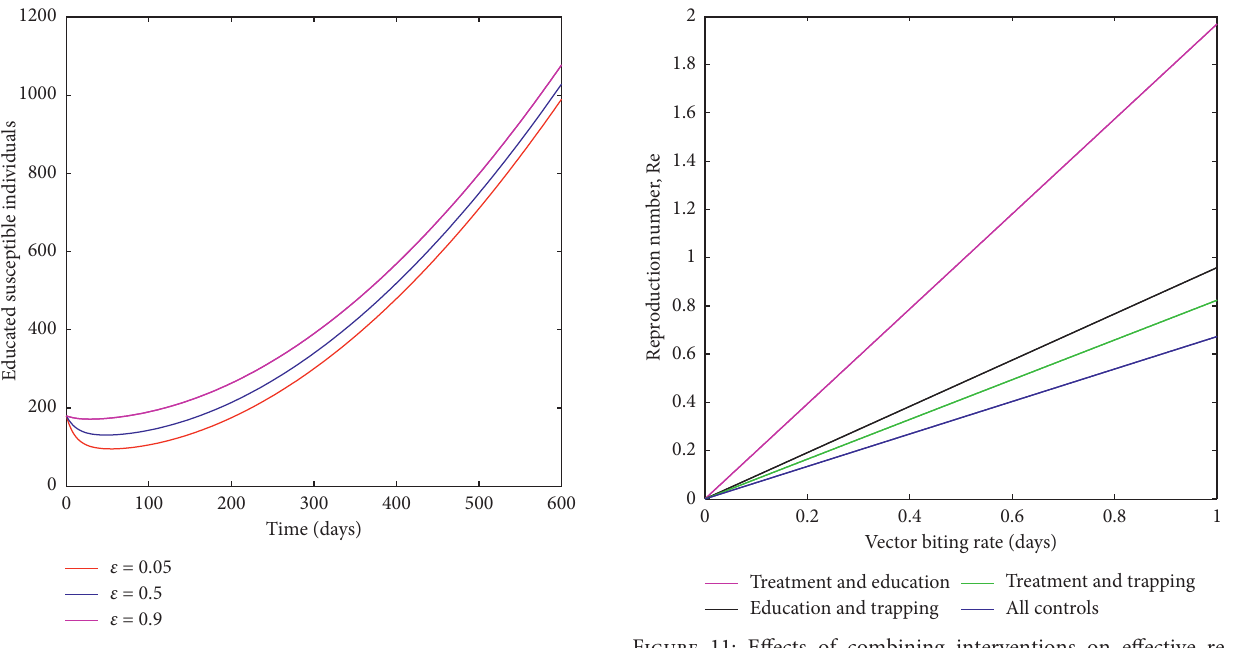
Figure 9: Variation in efficacy of public health education on susceptible human population.